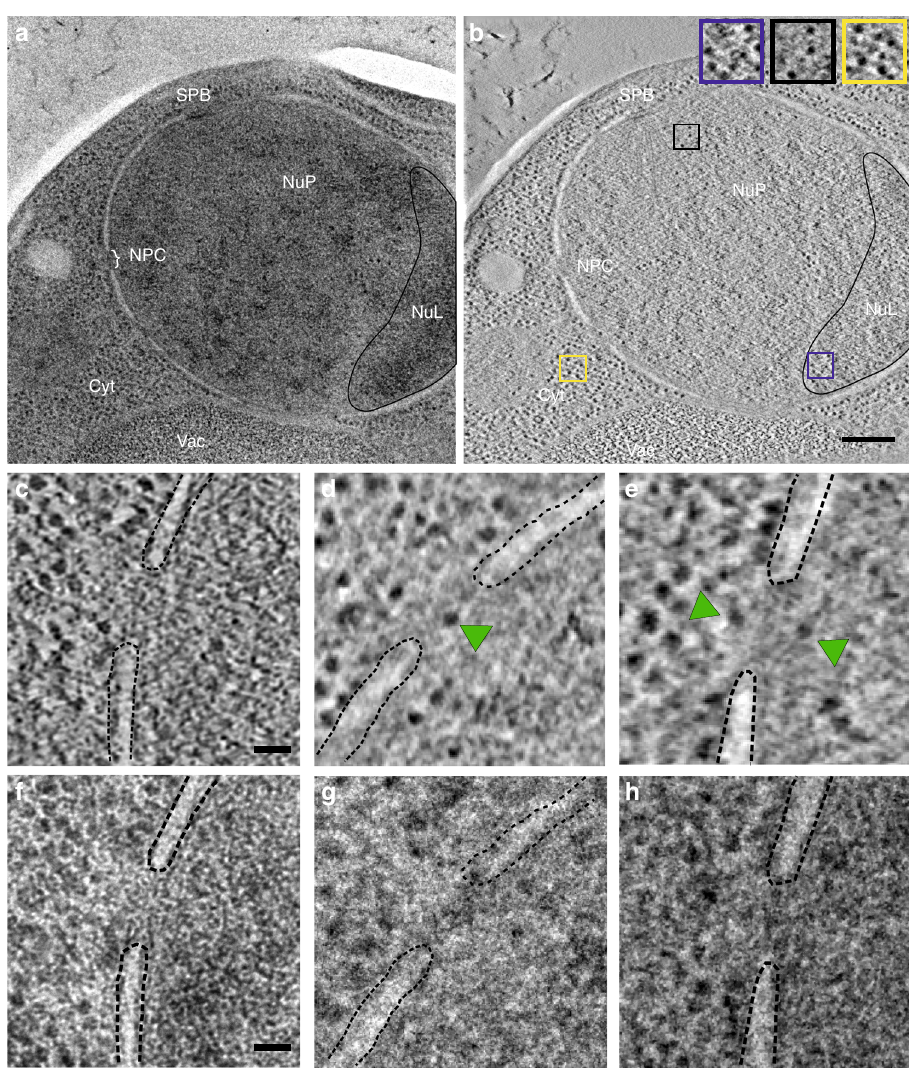
Fig. 1 Electron tomography reveals large cargoes in NPCs. a High-pressure frozen yeast cell visualized by conventional transmission electron microscopy. Vac: vacuole, Cyt: cytoplasm, NuP: nucleoplasm, NuL: nucleolus (black line), SPB spindle pole body and NPC nuclear pore complex. Scale bar: 200 nm. b A section of the electron tomogram showing the same area as in ( a ). Nuclear electron-dense particles are detected in the crescent-shaped nucleolus (blue frame) and the nucleoplasm (black frame), while ribosomes are visible in the cytoplasm (yellow frame). Scale bar: 200 nm. c – e A selection of electron tomography images showing NPCs containing one or two large particles (green arrowheads). f – g These particles are not seen by conventional transmission electron microscopy. The dashed lines delineate the nuclear envelope. Scale bar: 50 nm